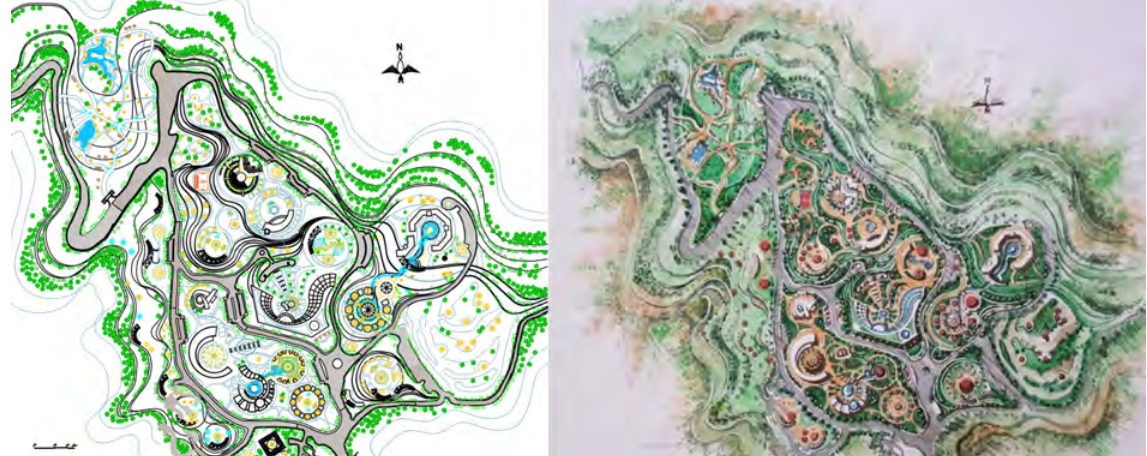
Figure 11. The master plan of the proposed park design(Source: Author).